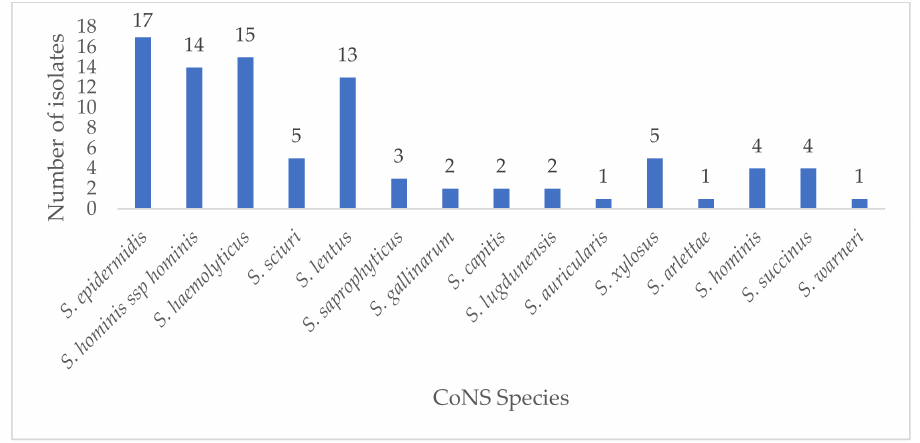
Figure 1. Distribution of CoNS isolates in this